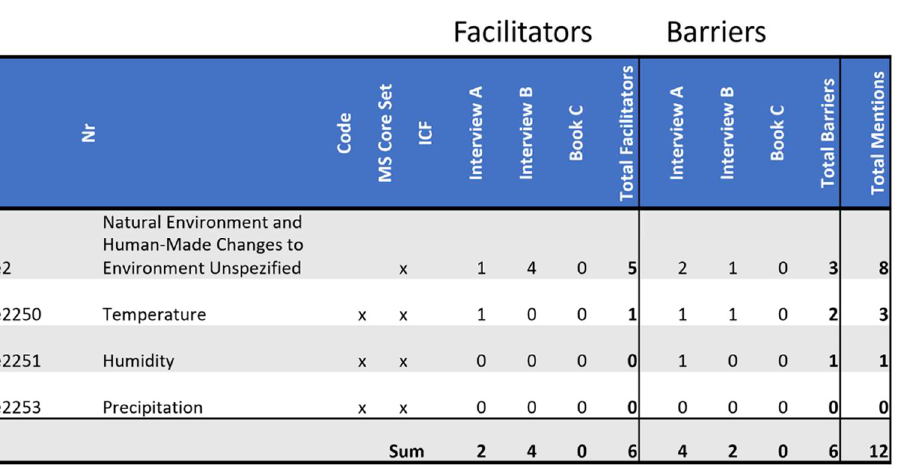
Figure 5. Distribution of codes in the domain e2 Natural Environment and Human-Made Changes to Environment : This figure shows the frequency of MS core set codes and non-core set codes of this domain referenced in each source as a facilitator and as a barrier. Additionally, it tallies all references throughout the domain as facilitators or as barriers by source, as well as tallying facilitators and barriers separately and together by code.